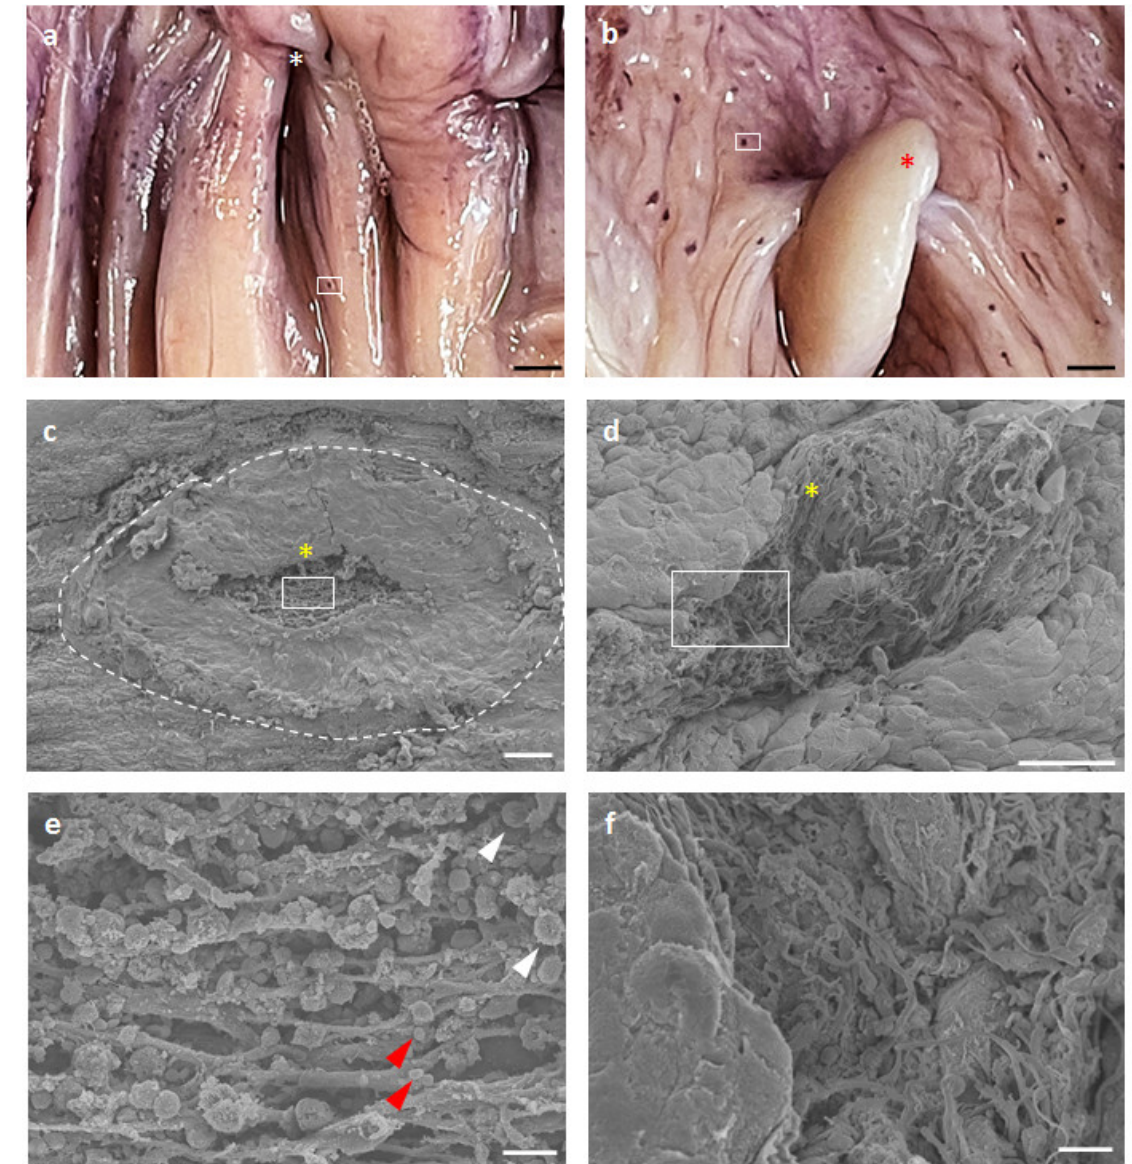
Figure 7. Ultrastructural characteristics of epithelium covering GOALT of the goat and pig. ( a , b ) Goat ( a ) and pig ( b ) VV mucosa stained in whole-mount with hematoxylin. GOALTs were observed as hematoxylin-positive blue spots. Scale bars = 2 mm. ( c , d ) Goat ( c ) and pig ( d ) VV mucosa were examined using SEM. The same areas as in panels ( a , b ) were examined. Dotted lines indicate GOALTs appeared on the surface of the epithelium. Yellow asterisks represent GOALTs opening into the VV lumen. Scale bars = 100, 50 μm. ( e , f ) Magnified areas squared in panels ( c , d ). White arrowheads indicate infiltration of lymphocytes from the GOALT to the lumen of the VV. Red arrowheads indicate erythrocyte. Red asterisk shows clitoris. Scale bars = 10 μm.